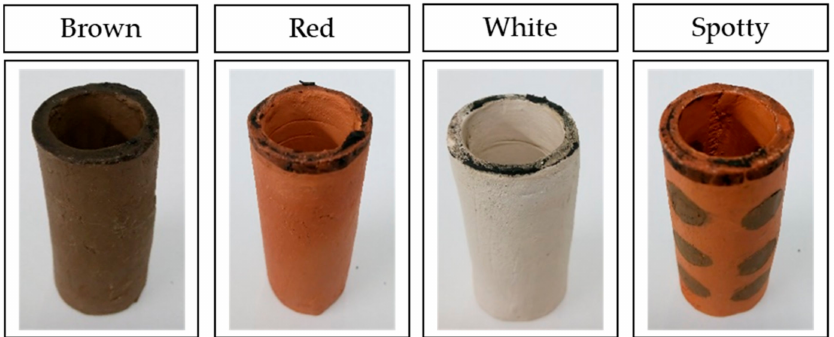
Figure 1. Images of ceramic cylinders used in the study. Spotty ceramics are exemplars of red ceramic-based with brown spots, named